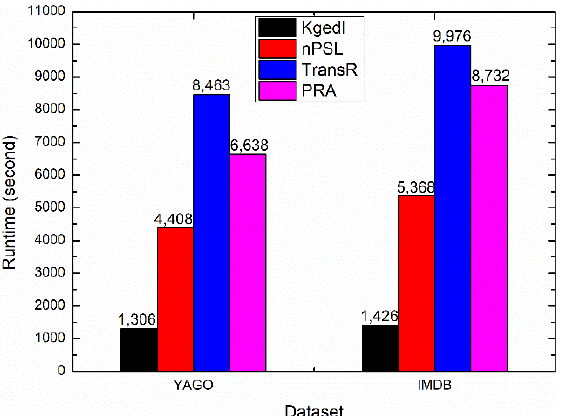
Figure 4. The runtime comparison between Kgedl and three baseline methods on the YAGO and IMDB datasets.